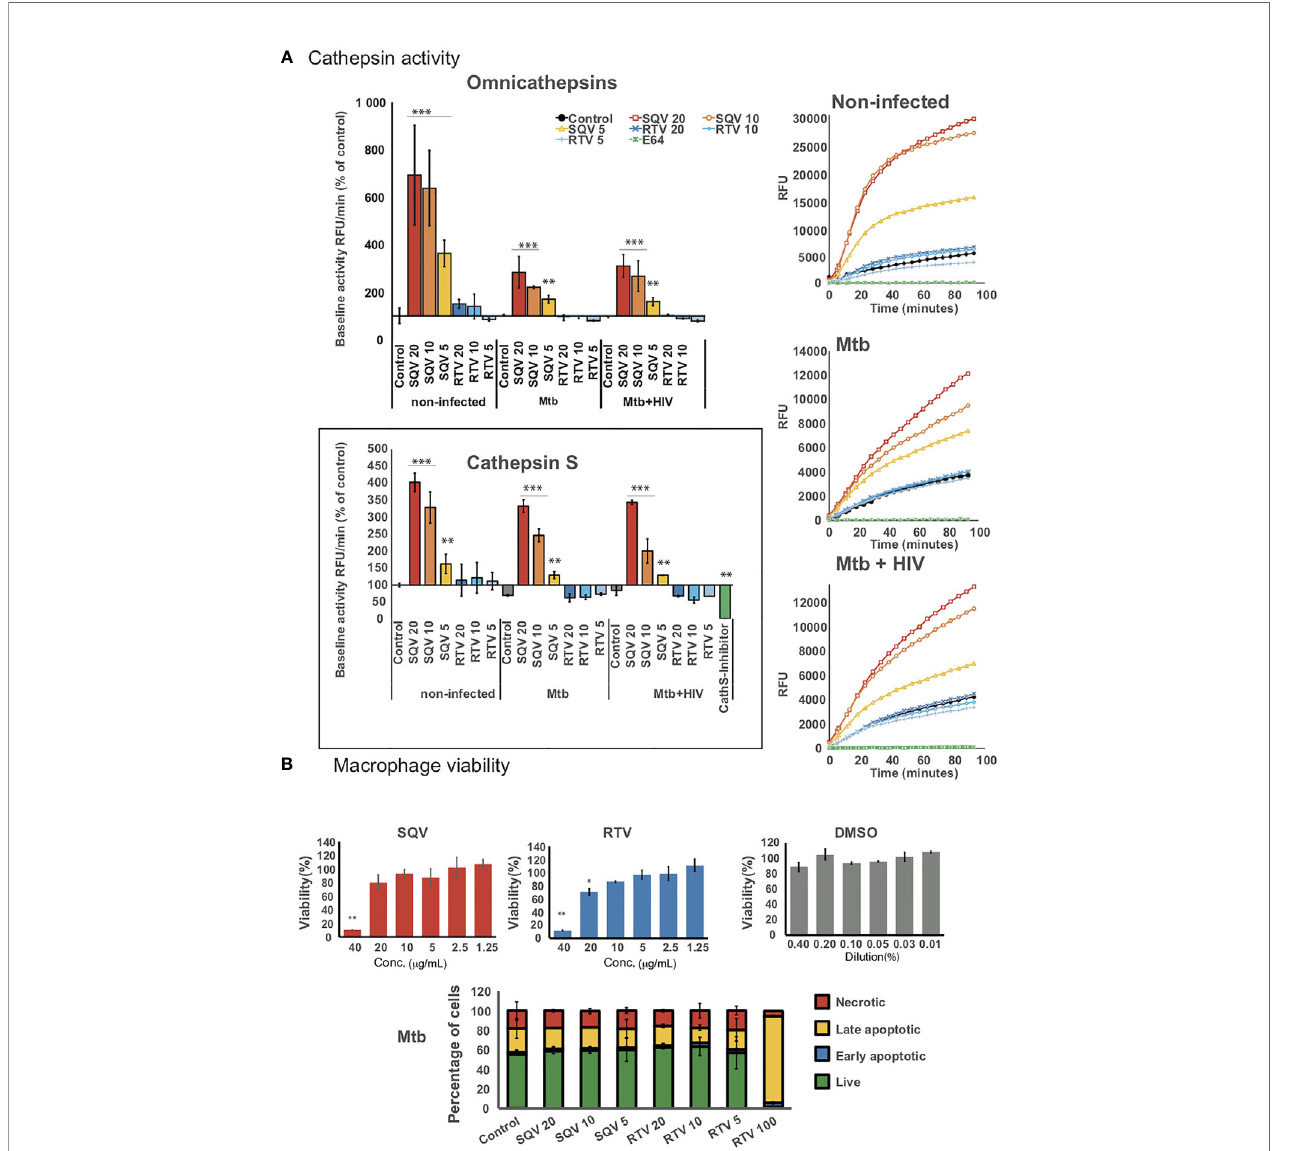
FIGURE 1 | HIV PIs alter cathepsins ’ activity in human macrophages infected with Mtb. (A) Omnicathepsin activity or cathepsin S activity alone were monitored with a speci fi c fl uorogenic substrate every 5 min in live cells pretreated with DMSO, RTV, SQV, or with speci fi c inhibitors (E-64d or ZFL-COCHOO for cathepsin S). The slope of fl uorescence emission in the presence of DMSO was represented as 100%, and the effect of each PI was calculated as a percentage of the DMSO control. Data are represented as average from three independent experiments and donors and data dispersion represented by the error bars as standard error (* P < 0.05, ** P < 0.01, *** P < 0.001 relatively to control). (B) Cell viability (upper bar-plots) was measured in non-infected cells treated for 3 days with the PIs and using PrestoBlue resazurin-based solution by quantifying the emission of fl uorescence in a plate reader. Cell death (lower bar-plot) was measured by fl ow cytometry after 24 h of infection using FITC-Annexin V and propidium iodide. Values show the average of three biological replicates from one representative experiment performed in triplicate while error bars depict standard deviation (* P < 0.05, ** P < 0.001 relatively to